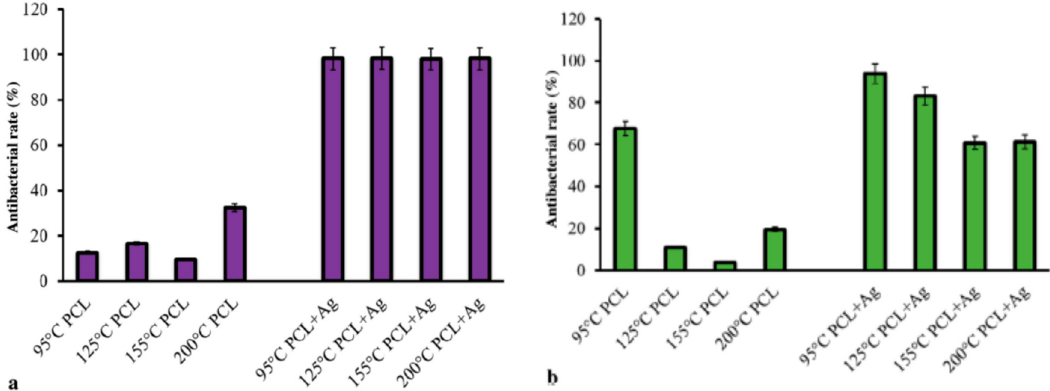
Figure 27. Antibacterial rates of PCL and AgNPs-loaded PCL fibrous mats prepared by pressurized melt gyration against ( a ) E. coli and ( b ) P. aeruginosa after 2 h of exposure. Reproduced with permission from [39]. Copyright Wiley-VCH,